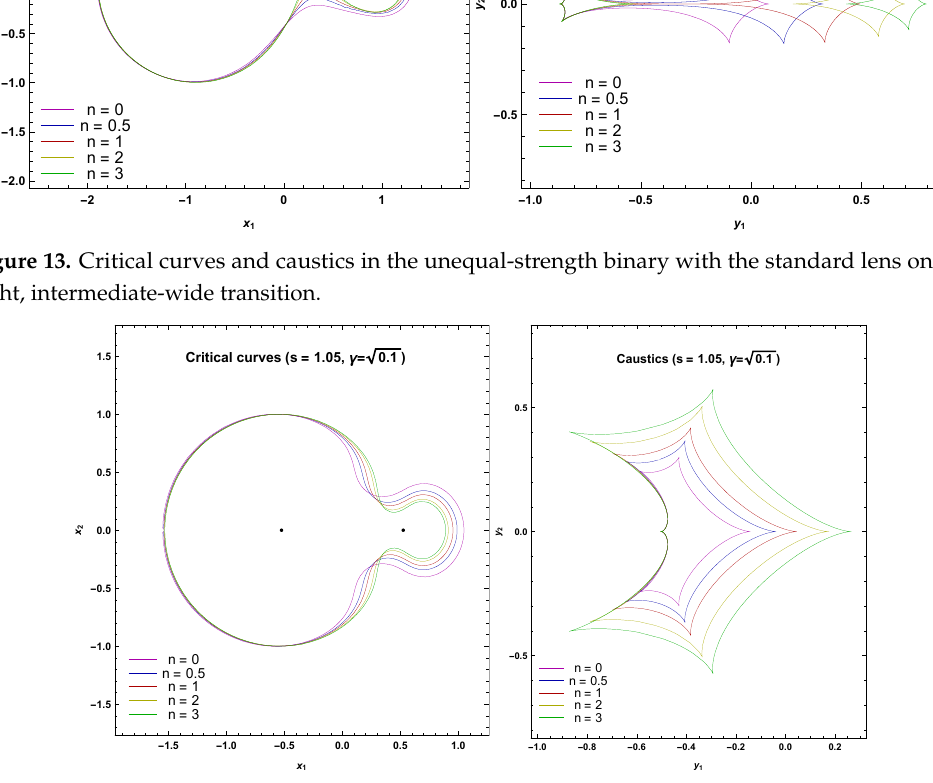
Figure 14. Critical curves and caustics in the unequal-strength binary with the standard lens on the right, intermediate separation.